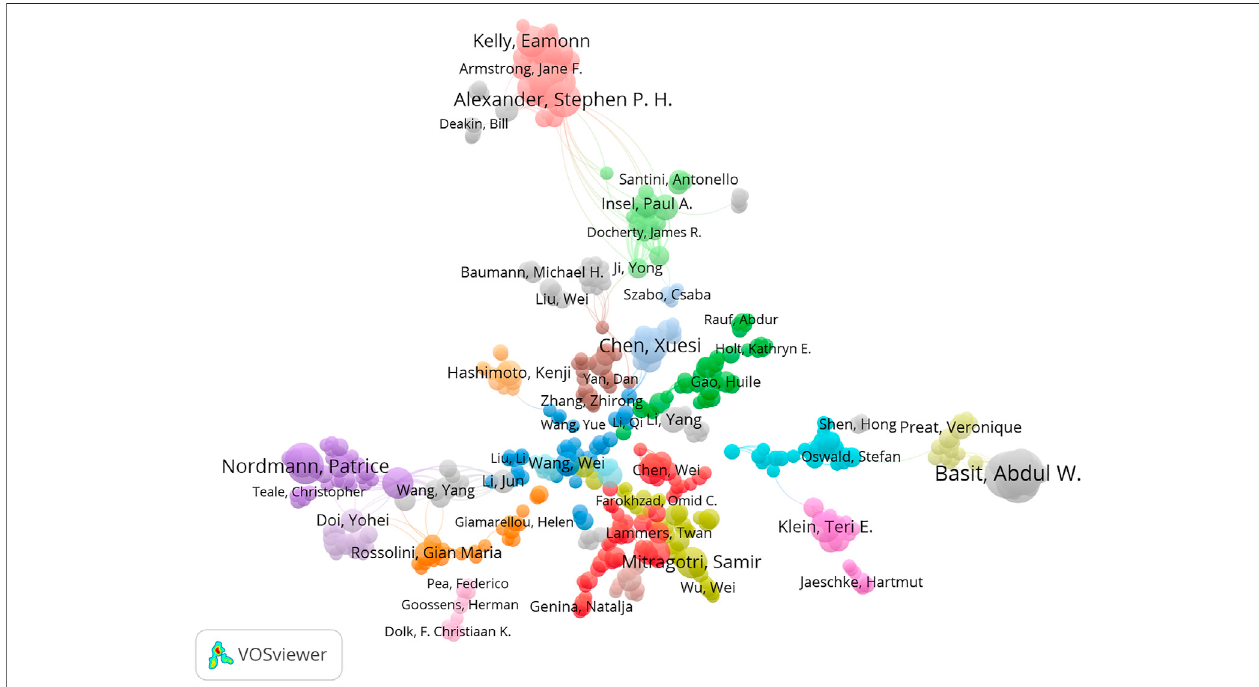
FIGURE 5 | Map of collaborative networks among the authors of high-impact papers in pharmacology and pharmacy research around the world.